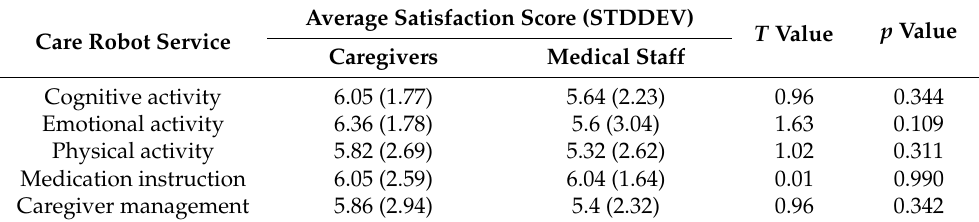
Table 1. Comparison of satisfaction with care robot services.